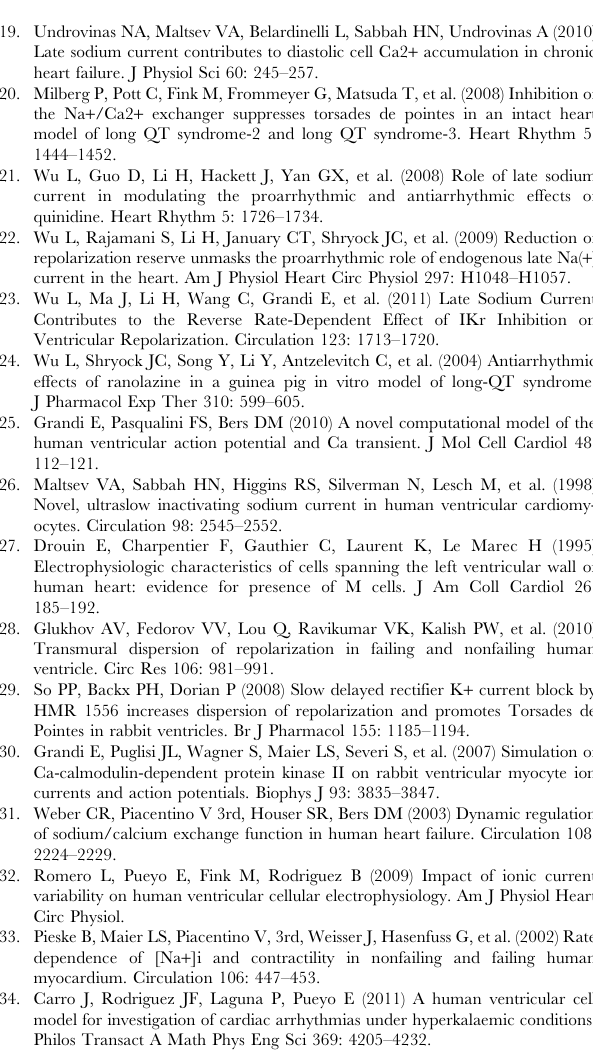
Figure S13 Mechanisms for early afterdepolarizations with a 50% transitory block of I rel . Simulated APs and ionic currents at 1-Hz pacing rate under HF conditions, 50% inhibition of I Kr , 30% increase of I CaL . Panel A shows EADs (dark line) with the basic HF value of I rel and APs with no EADs when I rel was 50% blocked (light line) during the 5 stimulations indicated by a horizontal line. The temporal evolutions of I NaL (panel B), [Ca 2 + ] SR (panel C), I rel (panel D), NCX activity (panel E), and activation gate of I CaL (panel F) are also depicted with the basic HF value of I rel (dark line) and when I rel was 50% blocked (light line) during the 5 stimulations indicated by a horizontal line. (TIF) Figure S14 Mechanisms for early afterdepolarizations with a 50% continuous block of I NCX . Simulated APs and ionic currents at 1-Hz pacing rate under HF conditions, 50% inhibition of I Kr , 30% increase of I CaL . Panel A shows EADs (dark line) with the basic HF value of I NCX and APs with no EADs when I NCX was 50% blocked (light line). The temporal evolutions of I NaL (panel B), [Ca 2 + ] SR (panel C), I rel (panel D), NCX activity (panel E), and activation gate of I CaL (panel F) are also depicted with the